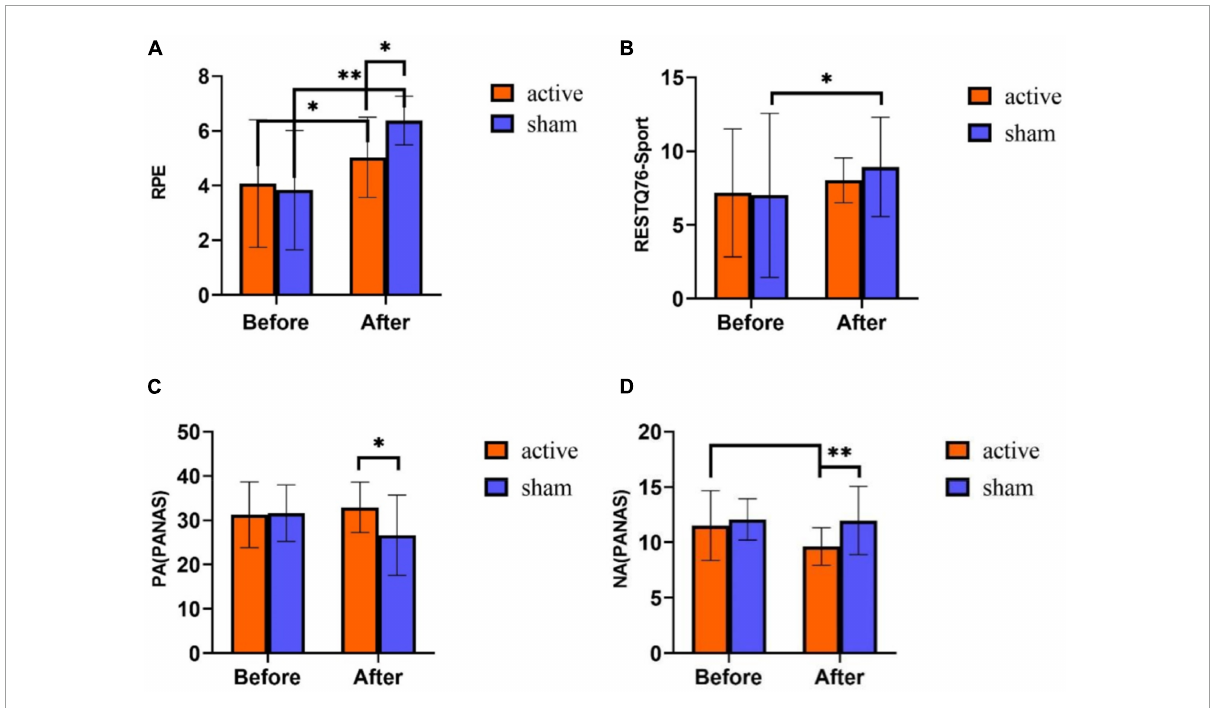
FIGURE3 Subjective report results of tPCS on athletic mental fatigue. (A) Rated perceived exertion (RPE) scale; (B) RESTQ76-Sport Questionnaire; (C) positive affect schedule (PANAS); (D) negative affect schedule (PANAS). ∗ p < 0.05, ∗∗ p <